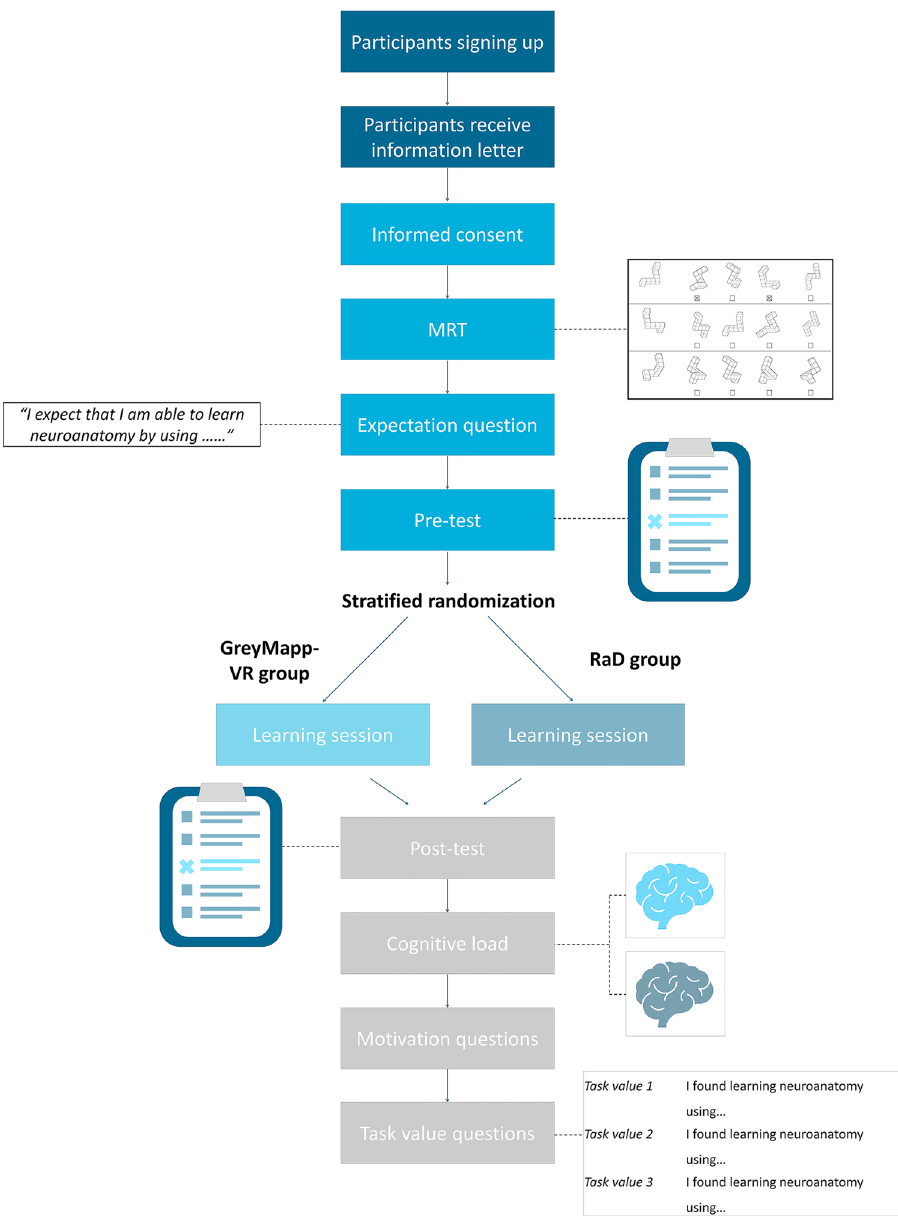
Figure 1. Schematic representation of the study design. MRT Mental rotation test, VR Virtual